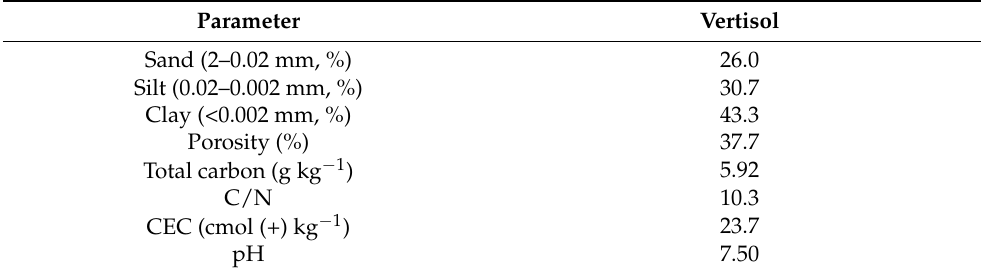
Table 1. Selected physicochemical properties of